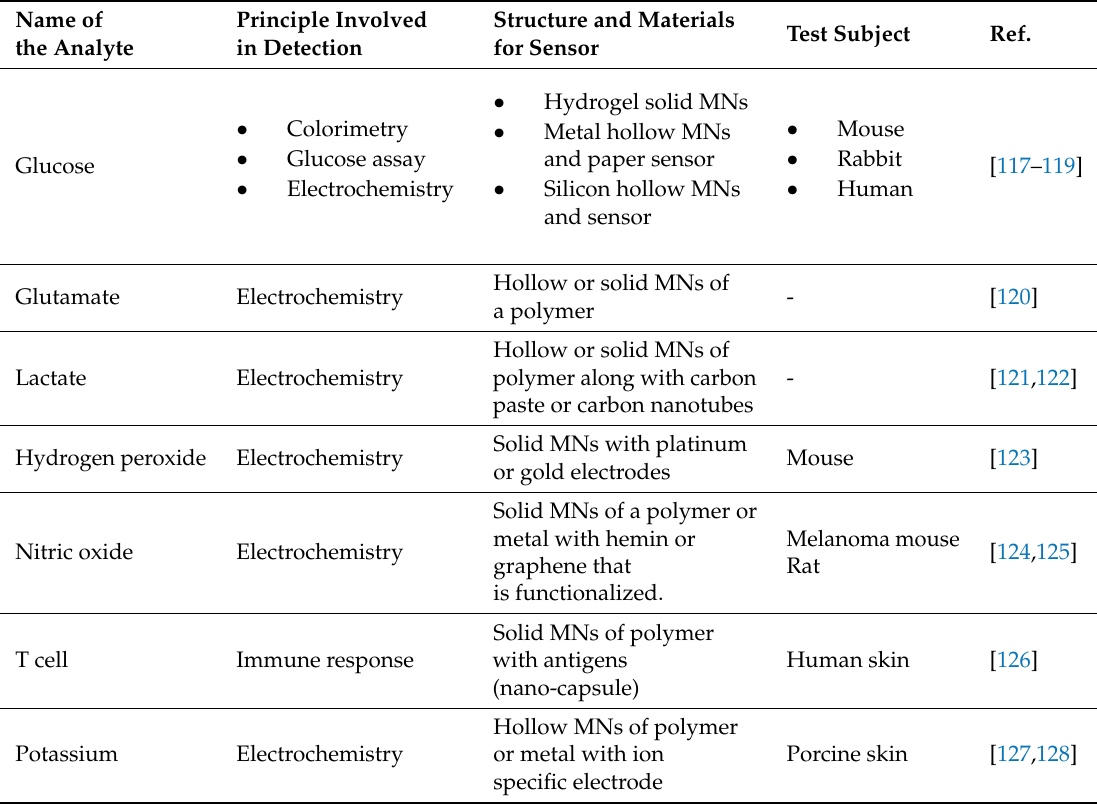
Table 1. Di ff erent types of analytes relied on to detect cancer using